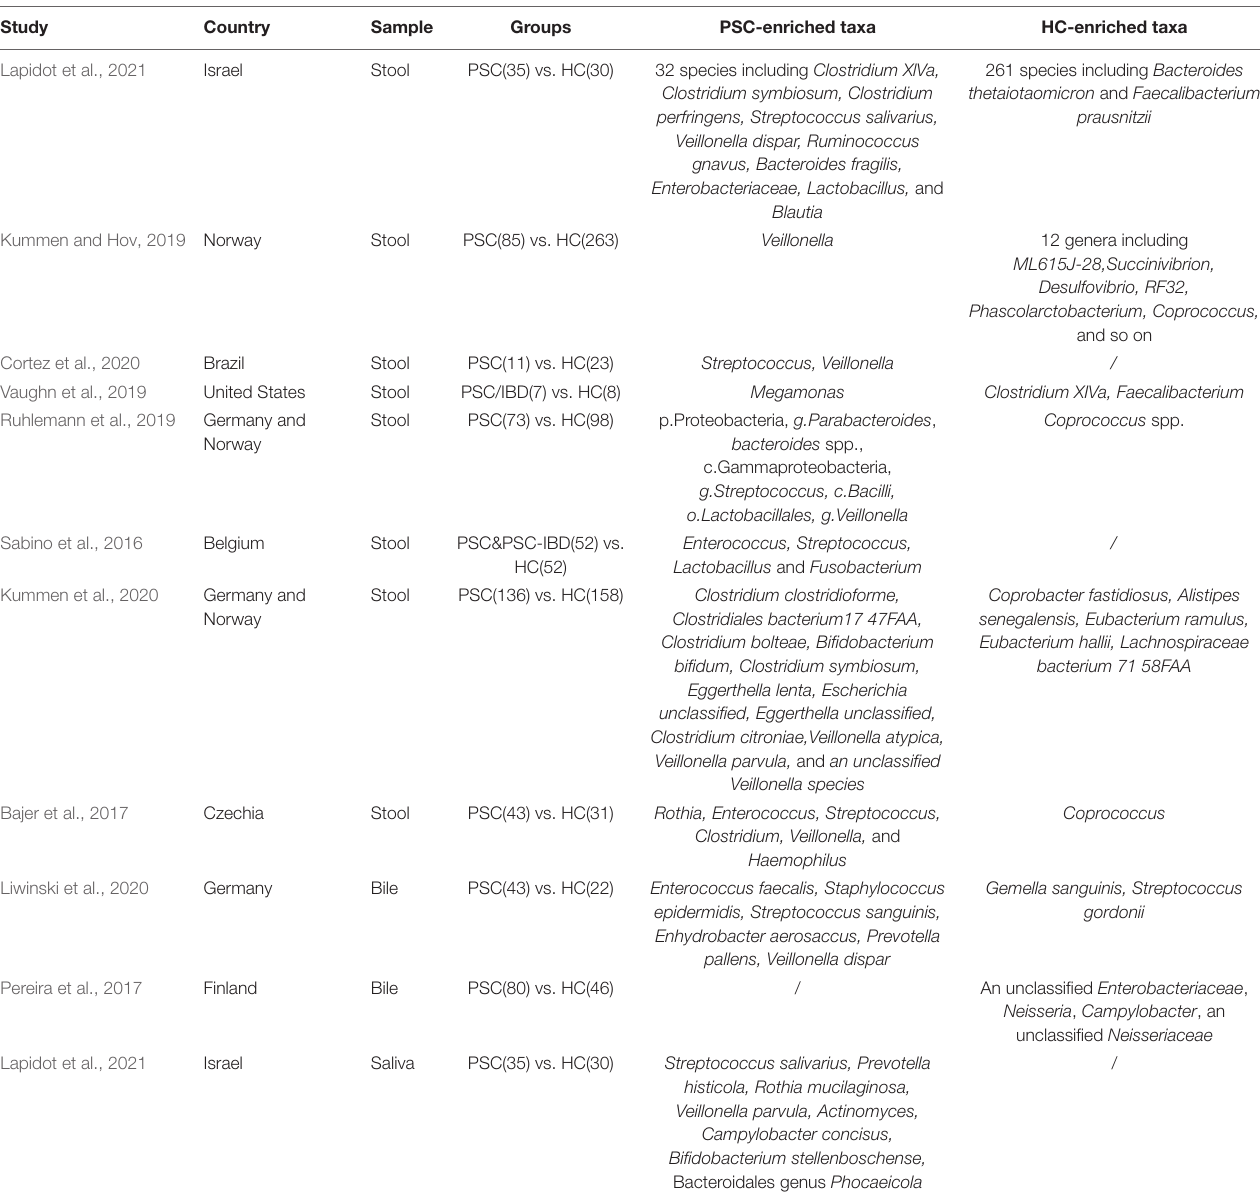
TABLE 4 | Study of the microbiome in primary sclerosing cholangitis